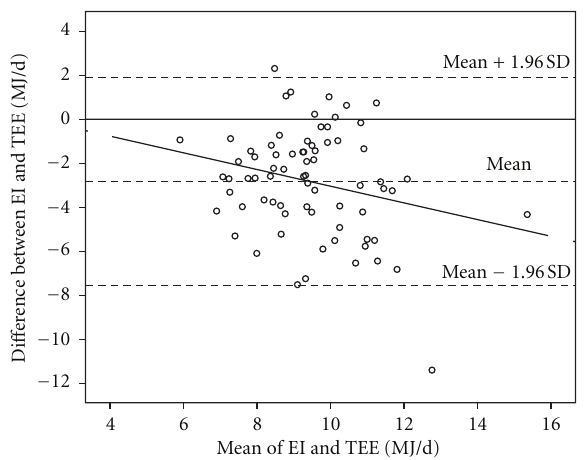
Figure 1: Di ff erence between assessed energy intake (EI) from esti- mated food records aided by digital camera and total energy expen- diture (TEE) registered with Sense Wear Armband in 73 children on the first assessment occasion, against the mean of the two variables. The correlation coe ffi cient of EI-TEE and mean of EI and TEE was − 0.24 ( P = 0 . 04) and the regression equation was y = 0 . 74 ± 0 . 38 x ( P = 0 .